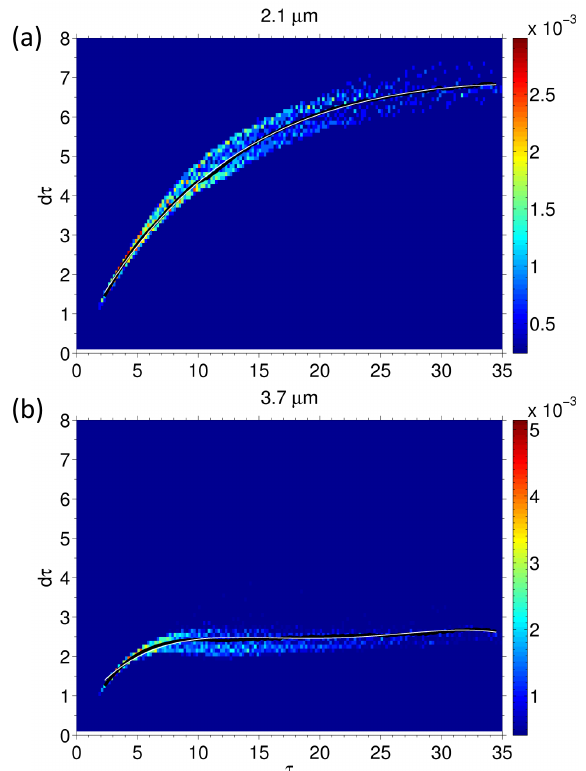
Figure 2. As for Fig. 1 except for d τ as a function of τ and using Eq. (15) for the white